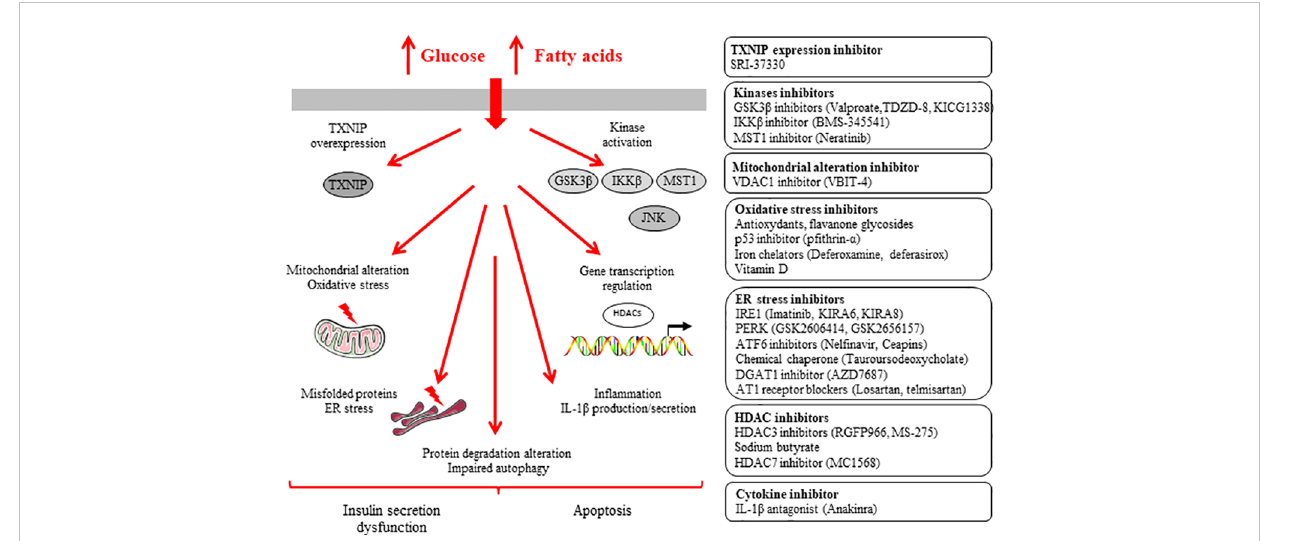
FIGURE 2 Inhibitors of b -cell dysfunction and death induced by glucotoxicity and